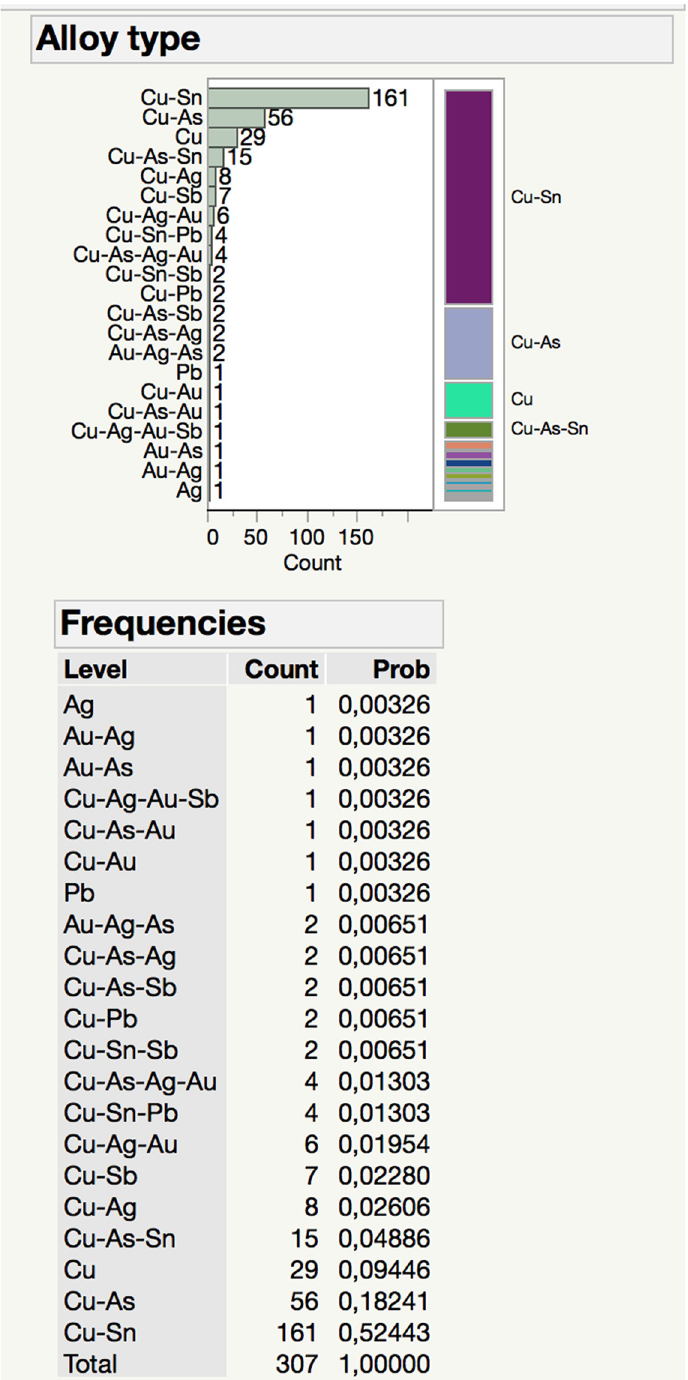
Fig 8. Distribution of metal and alloy types in the analyzed metal corpus of Resulo ğ lu.